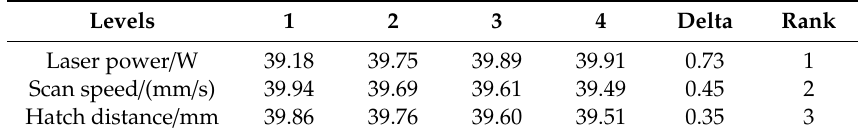
Figure 10. Main effect plots of signal ‐ to ‐ noise (S/N). Figure 10. Main e ff ect plots of signal-to-noise (S / N). Table 3. Response for the signal-to-noise (S / Table 3. Response for the signal ‐ to ‐ noise (S/N).